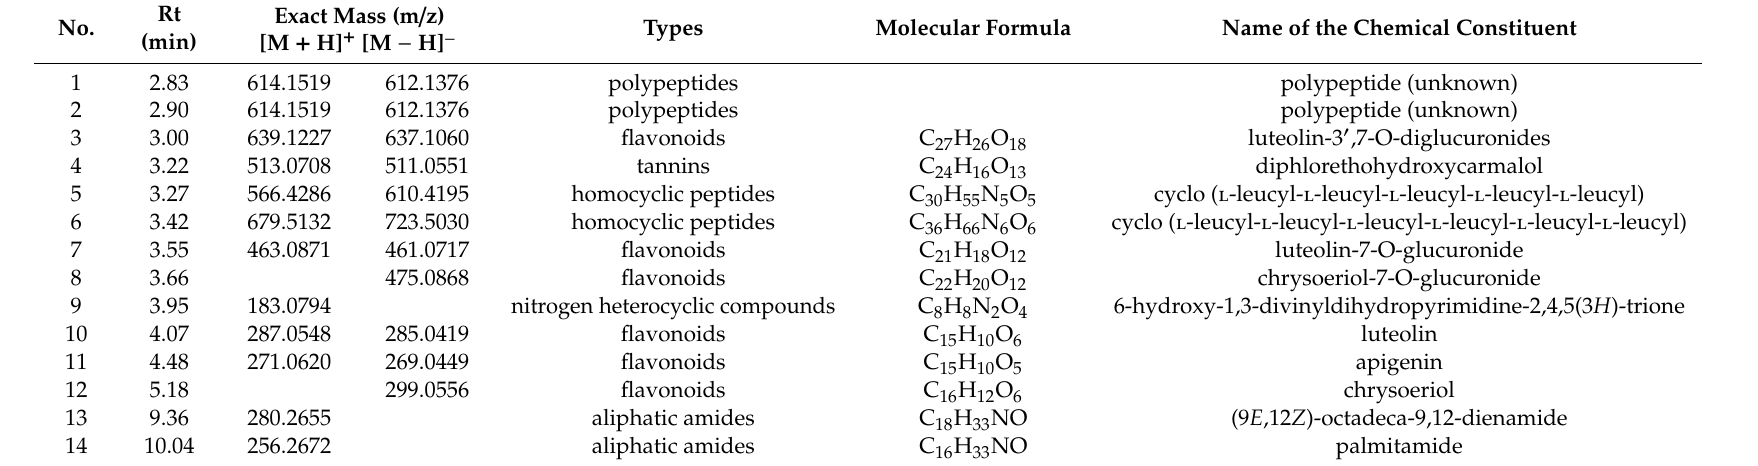
Table 1. Identification of chemical constituents from E. acoroides aqueous